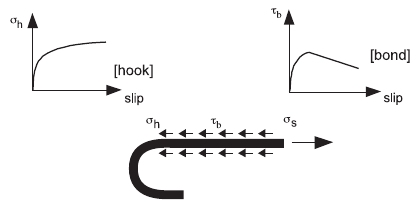
Fig. 9. Element for the hooked